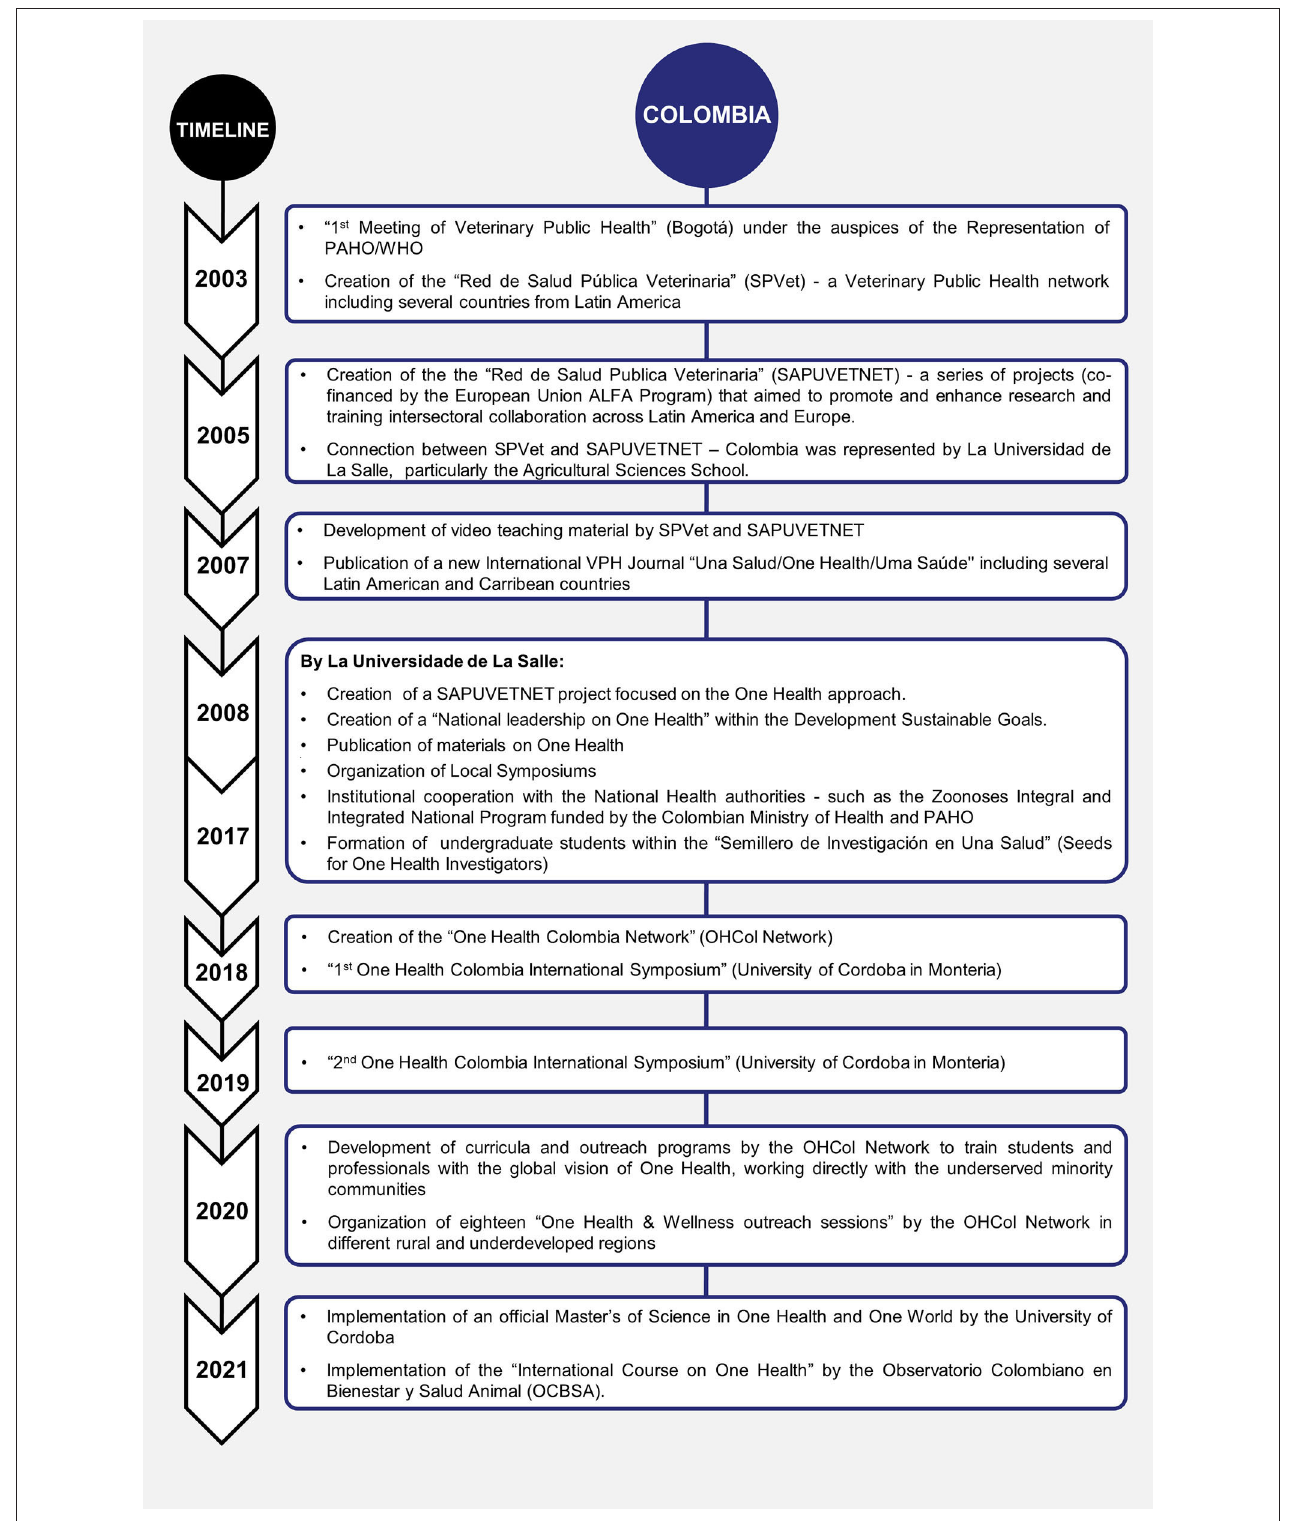
FIGURE 3 | One Health history and development in the last decades in Colombia.